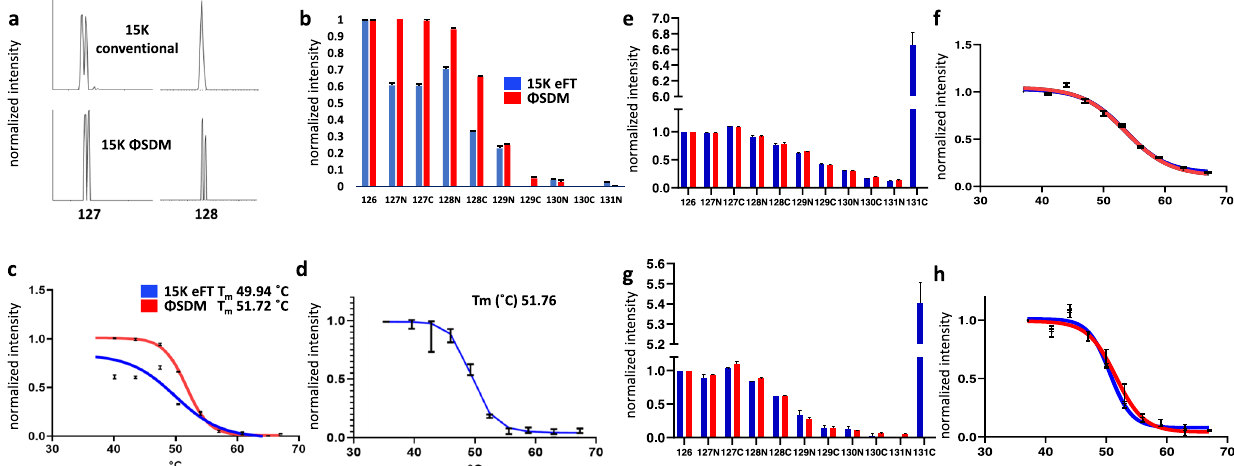
Fig. 2 Feasibility of using Φ SMD and stable isotope isobarically labeled cell culture (SIILCC). a An example of reporter ion isotopologues ± Φ SDM. Insuf fi cient resolving power results in reporter ion coalescence (top, for illustrative purposes, data was collected in pro fi le mode) using the conventional eFT mode of MS data acquisition, while the Φ SMD-based approach allowed for resolving closely spaced reporter ions. b Proportional heat response was not observed in MEK2 reporter ion intensities acquired with conventional eFT MS data acquisition at 15 K resolution setting compared to MEK2 reporter ion intensities acquired at 15 K resolution setting using Φ SDM. c MEK2 melting curves acquired with and without Φ SDM show differences in T m and melting curve pro fi les. d MEK2 melting curve from the “ Meltome ” database as a reference melting curve. e Median reporter ion intensities acquired with and without SIILCC demonstrating the negligible effect of the SIILCC carrier channel on the performance of TSA measurements. f Median fi tted protein level melting curves with and without SIILCC showing high similarity. g MEK2 reporter ion intensities acquired with and without SIILCC. h MEK2 fi tted protein level melting curves with and without SIILCC demonstrating high similarity in curve pro fi les and T m values. The error bars represent the standard deviation ( n = 2 for e and g , and n = 3 for b , c , f , and h